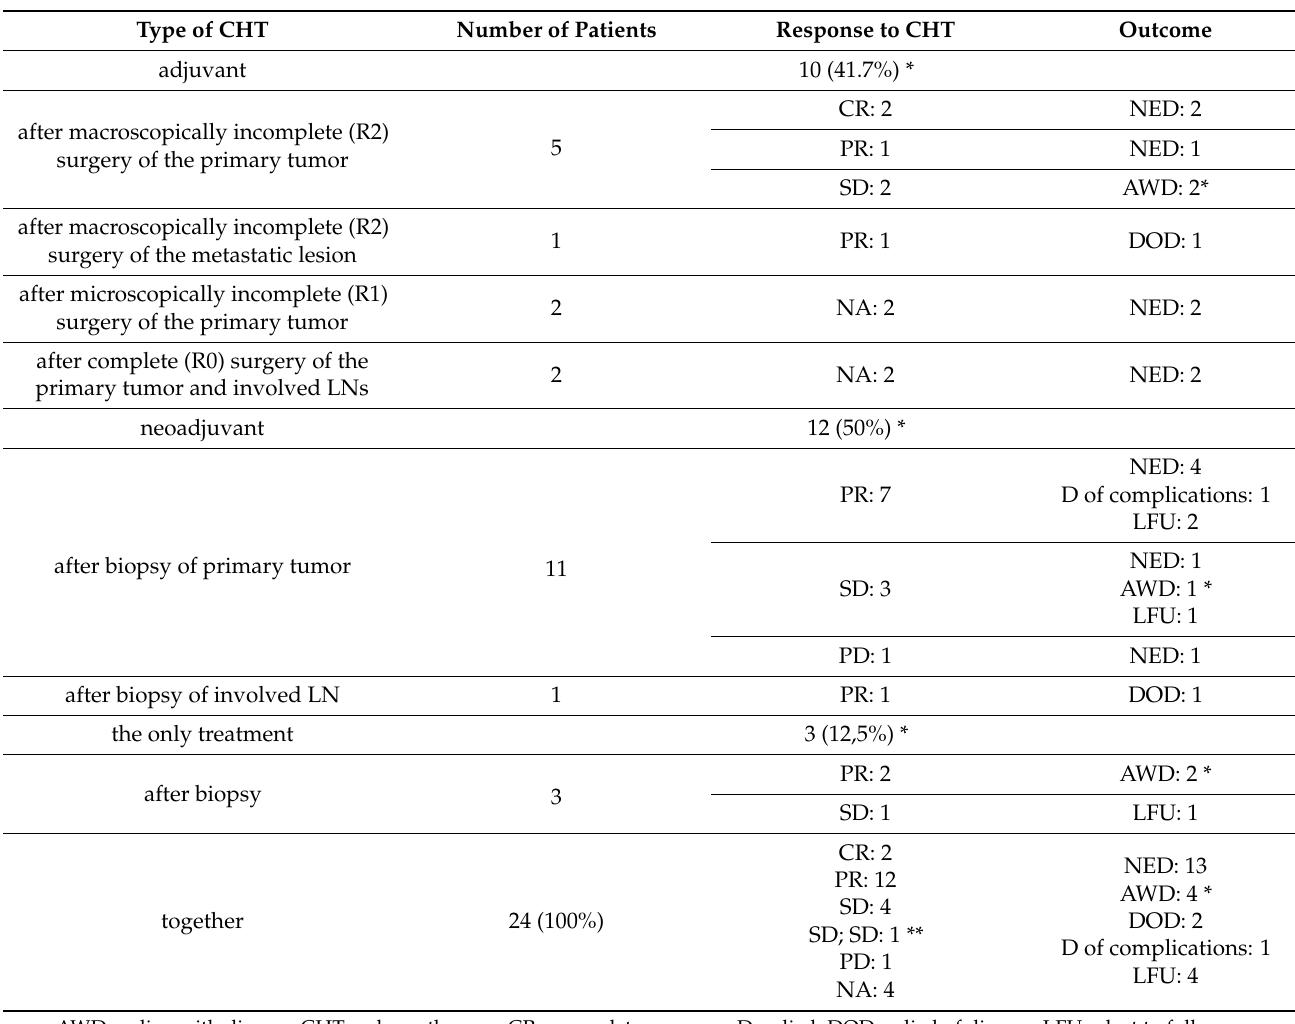
Table 6. Summary data of the patients receiving CHT in the first-line treatment of MNTI (n = 24). Type of CHT Number of Patients Response to CHT Outcome adjuvant 10 (41.7%)